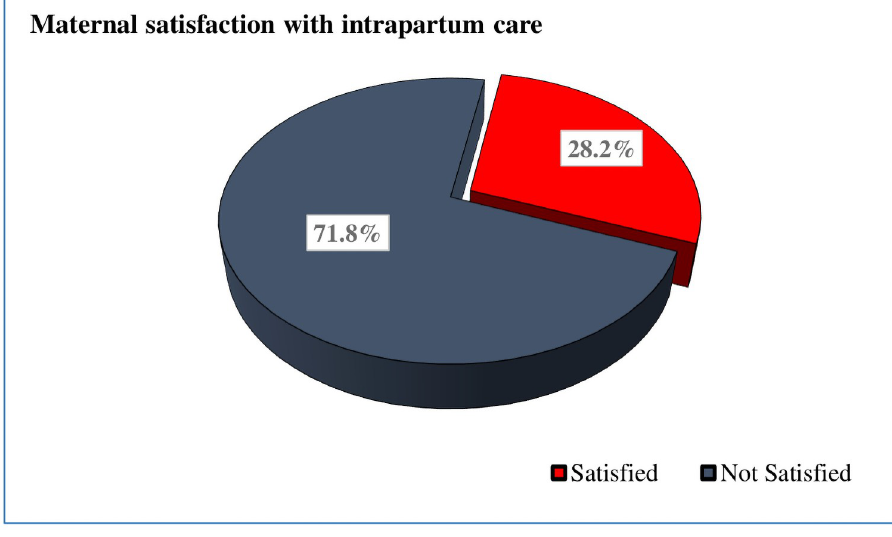
Fig 1. Maternal satisfaction with intrapartum care among postpartum women at public hospitals of North Shoa Zone, Ethiopia (n =